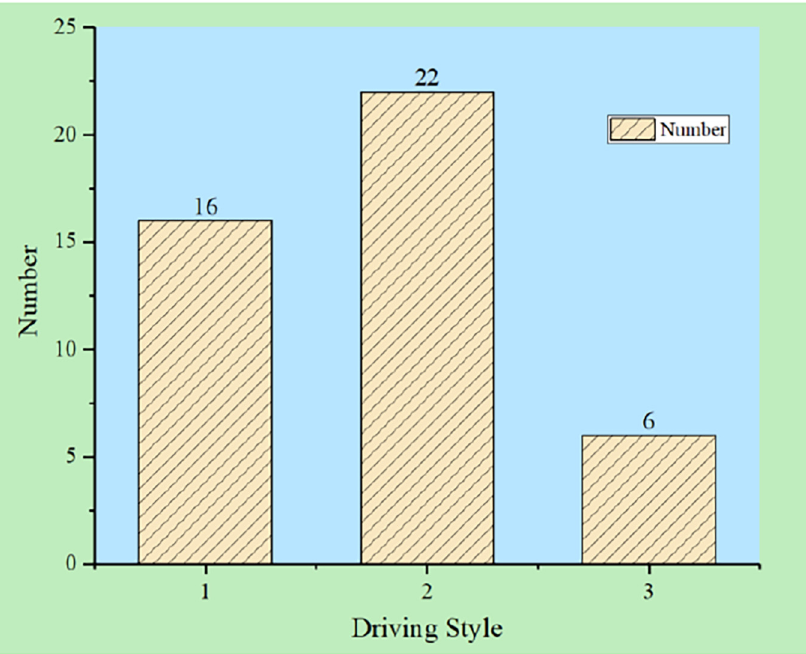
Figure 4 Driving style labeled results